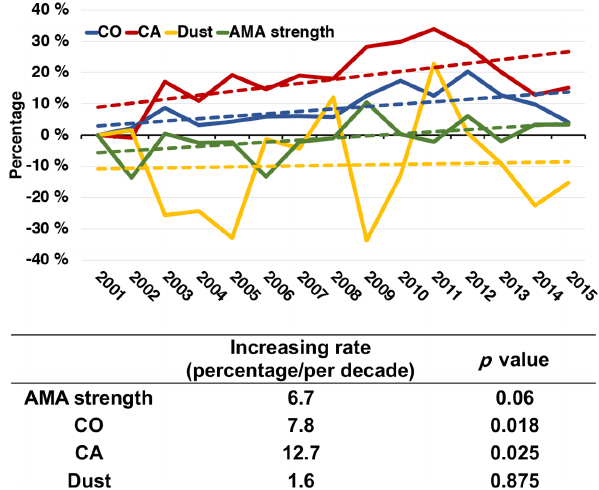
Figure 7. Time series of CO, CA, dust and AMA strength anomalies (percentage) relative to the first year during 2001–2015. The loading of CO, CA and dust is area-averaged over the selected region (that is, 25–35 ◦ N, 60–120 ◦ E). The AMA strength is calculated from the percentage difference in zonal wind averaged between 30 and 40 ◦ N minus zonal wind averaged between 10 and 20 ◦ N along the sector 60–120 ◦ E. The increasing rate and p value from the significance test for each variable are shown in the table below the